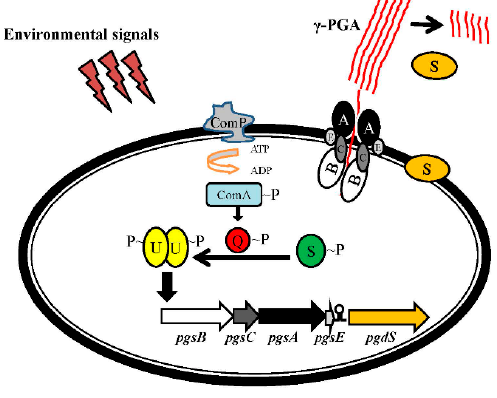
Figure 9. Regulation of the pgsBCA gene cluster: A, pgsA ; B, pgsB ; C, pgsC ; E, pgsE ; U, degU ; Q, degQ ; S, degS .